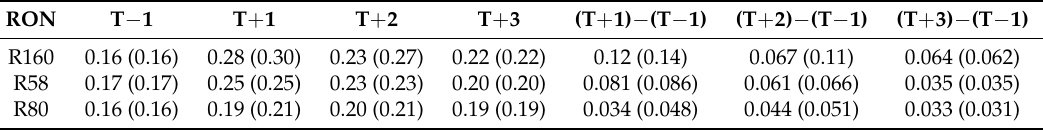
Figure 8. Boxplots of coherence and time separation from a mowing event. Grey boxplots represent unfiltered data, while white boxplots represent the precipitation filtered data. Table 4. Median coherence values for time separation groups and VH polarisation. Values without parentheses indicate unfiltered data, while precipitation filtered data is given in